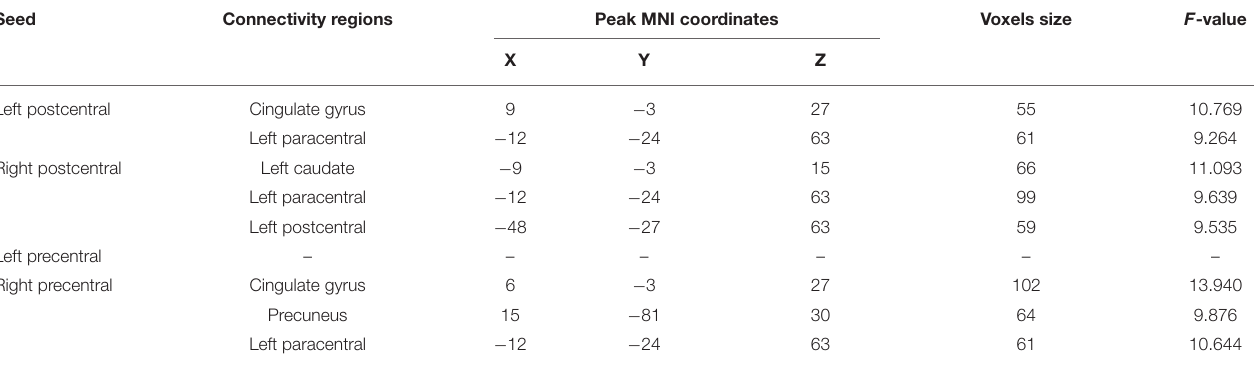
TABLE 3 | Differences in seed-based functional connectivity (FC) among LCSP, RCSP, and